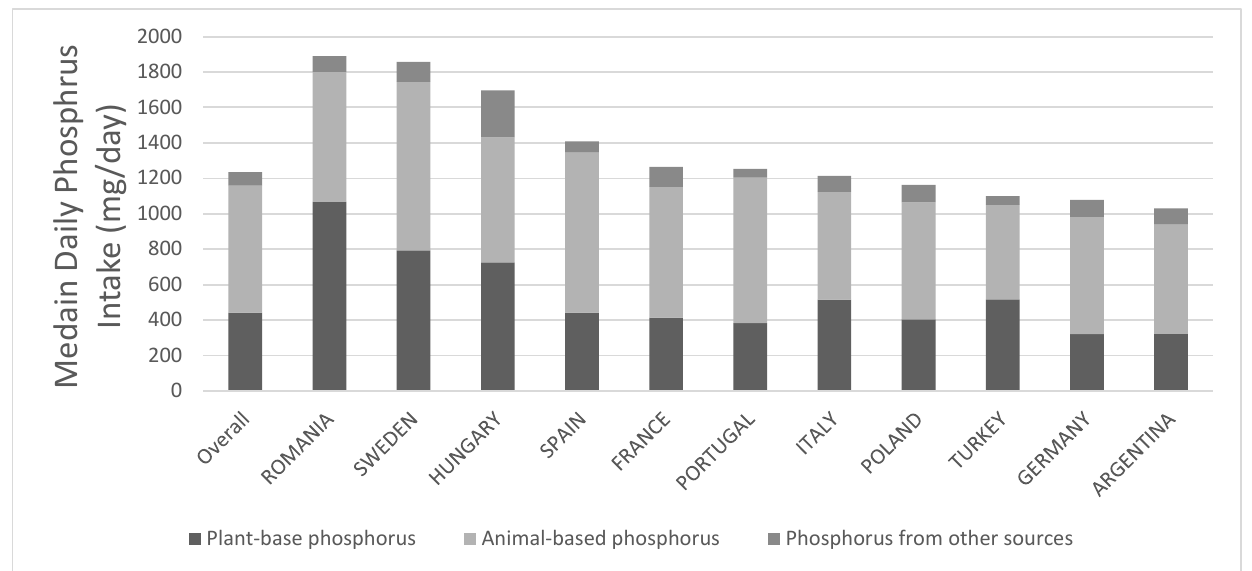
Figure 1. The median intake of dietary phosphorus (mg/day), stratified by food source and country.